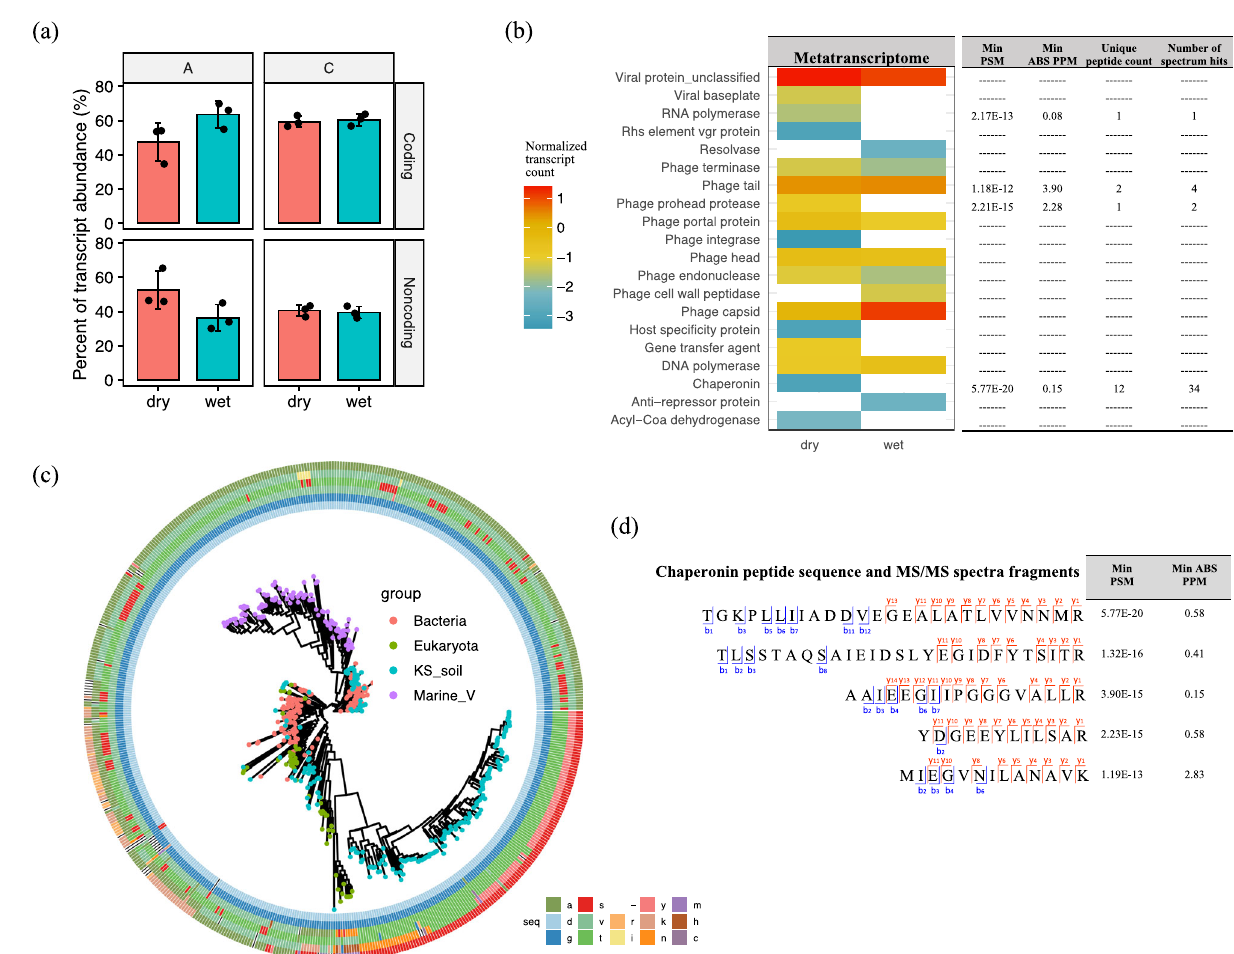
Fig. 3 Functional characterization of viral transcripts and proteins. a The percentage of the quality- fi ltered transcripts that mapped to gene-coding and noncoding regions of DNA viral contigs. The percentage of noncoding transcripts trended towards higher, but not signi fi cant, levels in drier soils at site A. b Counts of viral structural/functional groups that were detected in both the metatranscriptomes (heatmap on the left) and metaproteomes (table on the right). c A phylogenetic tree based on the protein alignment of bacterial (red), eukaryotic (green), and soil (blue)/marine (purple) viral chaperonins (GroEL-like). The soil viral chaperonin protein sequences were translated from the predicted genes in transcribed DNA viral contigs. An example of a conserved region (position 1 – 6 of the trimmed multiple sequence alignments in Supplementary Data 6) is shown in a six-track ring outside the tree and the six tracks represent the six amino acids from that region in order from the inner to the outer rings. The corresponding amino acid of the conserved region in each chaperonin sequence is color-coded and speci fi ed in the fi gure key. d Examples of highly con fi dent viral chaperonin peptide sequences with their observed fragmentation ions (blue for b-ions and red for y-ions) in MS/MS spectra, along with their minimal peptide-spectrum match (PSM) scores and minimal mass error of precursor ions (PPM) from MSGF + search